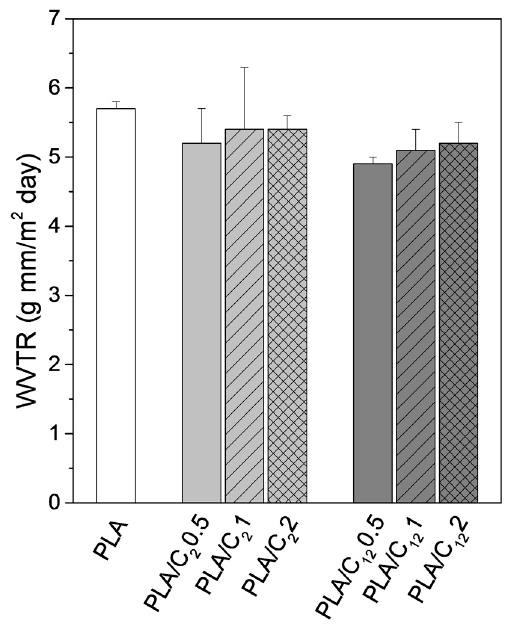
Figure 9. WVTR of PLA films and PLA nanocomposites.